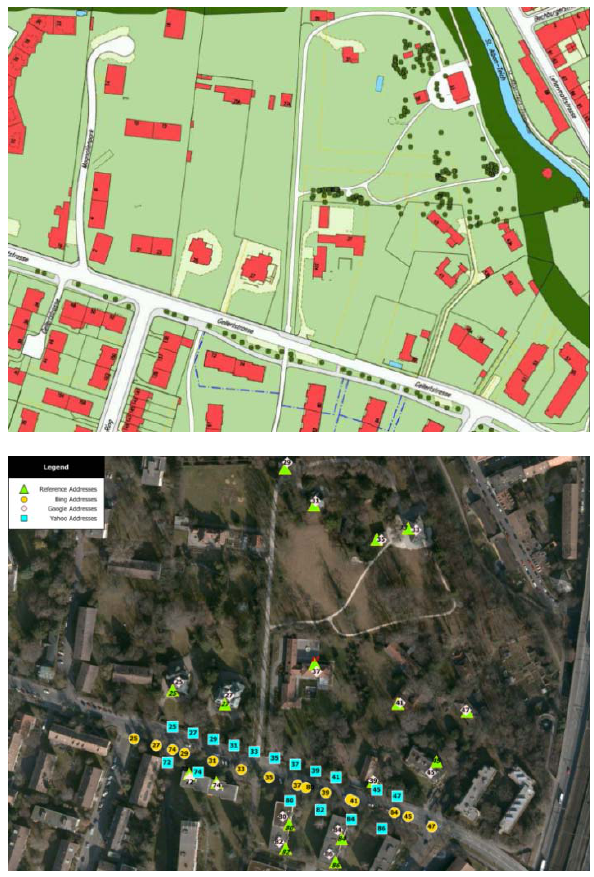
Figure 53: Part of canton of Solothurn, from Stark (2012). The cadastral map at the top shows correct house locations. At the bottom are the attempts by Google Maps, Bing and Yahoo! Maps to locate addresses on an air photo background, with the reference locations